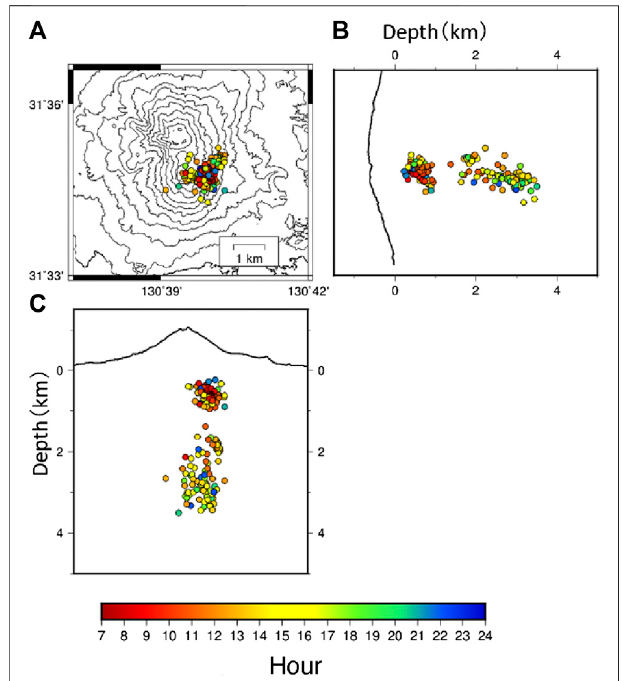
FIGURE 7 | Hypocenter distributions of the VT earthquakes on August 15,2015,asdeterminedbythedouble-differencemethod.Thecolorsindicate theoccurrencetime. (A) Mapviewoftherelocatedhypocenters.Contoursare provided every 100 m. (B) and (C) are the EW and NS cross sections,